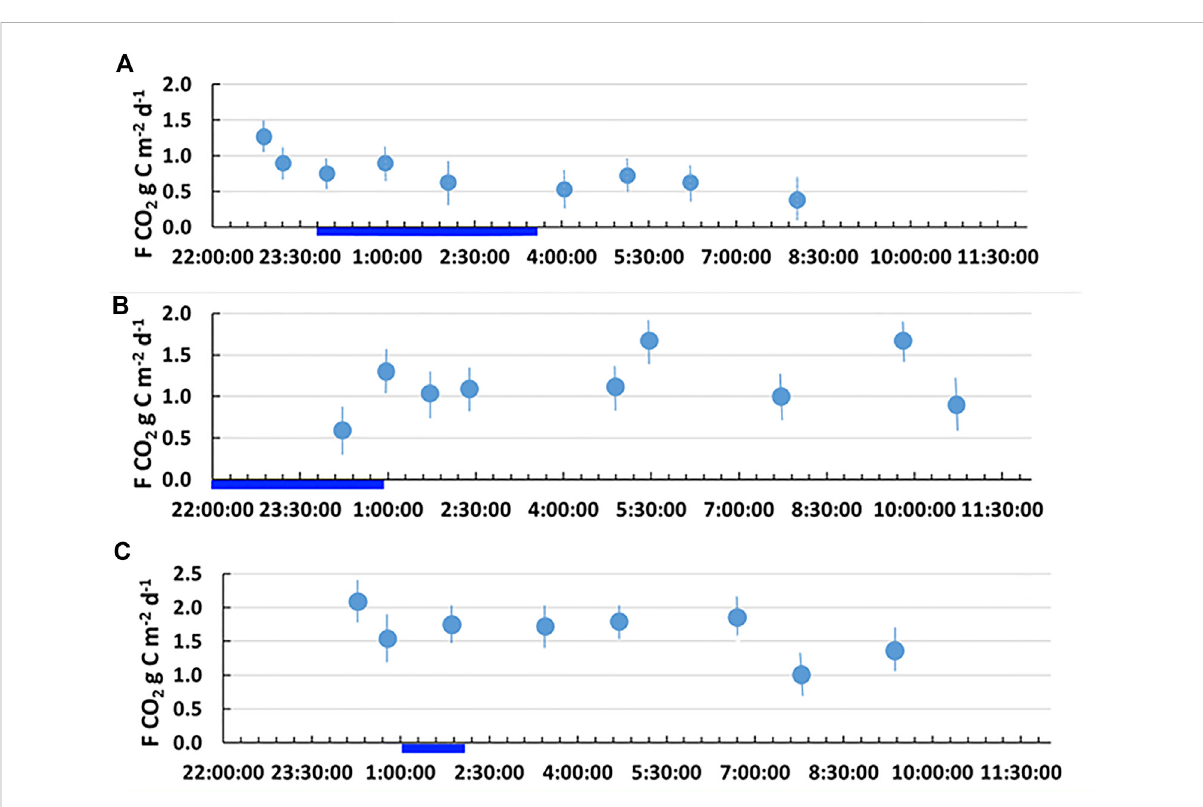
FIGURE 3 Discrete chamber-based fl uxes in the Taz River [ (A) : 46.3 km, main stem (Tz-3), 64.07712 ° N, 81.93293 ° E] and two tributaries [ (B) : Chaselka (Tz- 7), 211 km, 64.9391 ° N, 81.3651 ° E: (C) Soryakha, 566 km, 66.982628 ° N, 81.519432 ° E] including night time measurements (thick black line). Variations of water temperature did not exceed 2 °